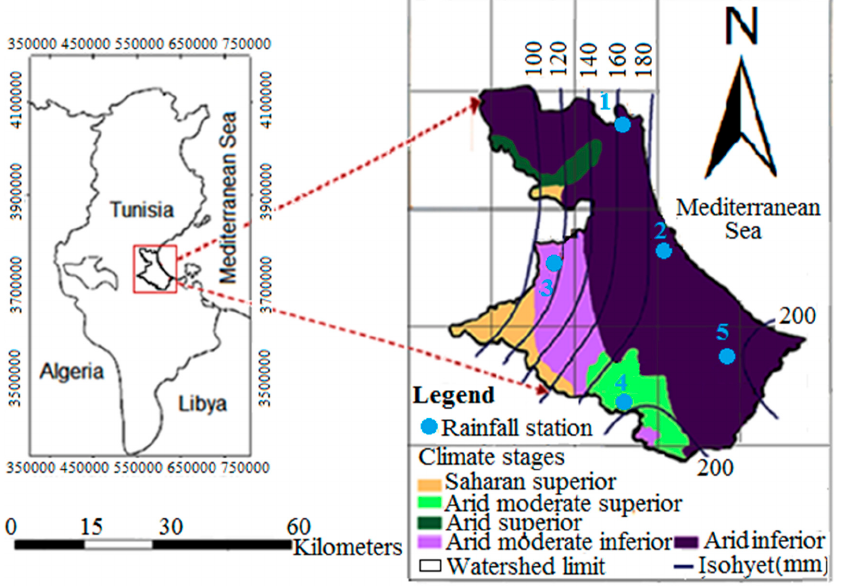
Figure 2. Bioclimatic map of Gabes Watershed.